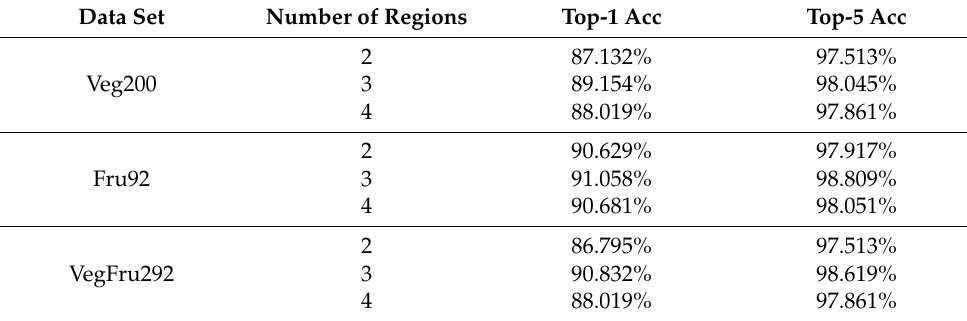
Table 2. An evaluation of different numbers of informative